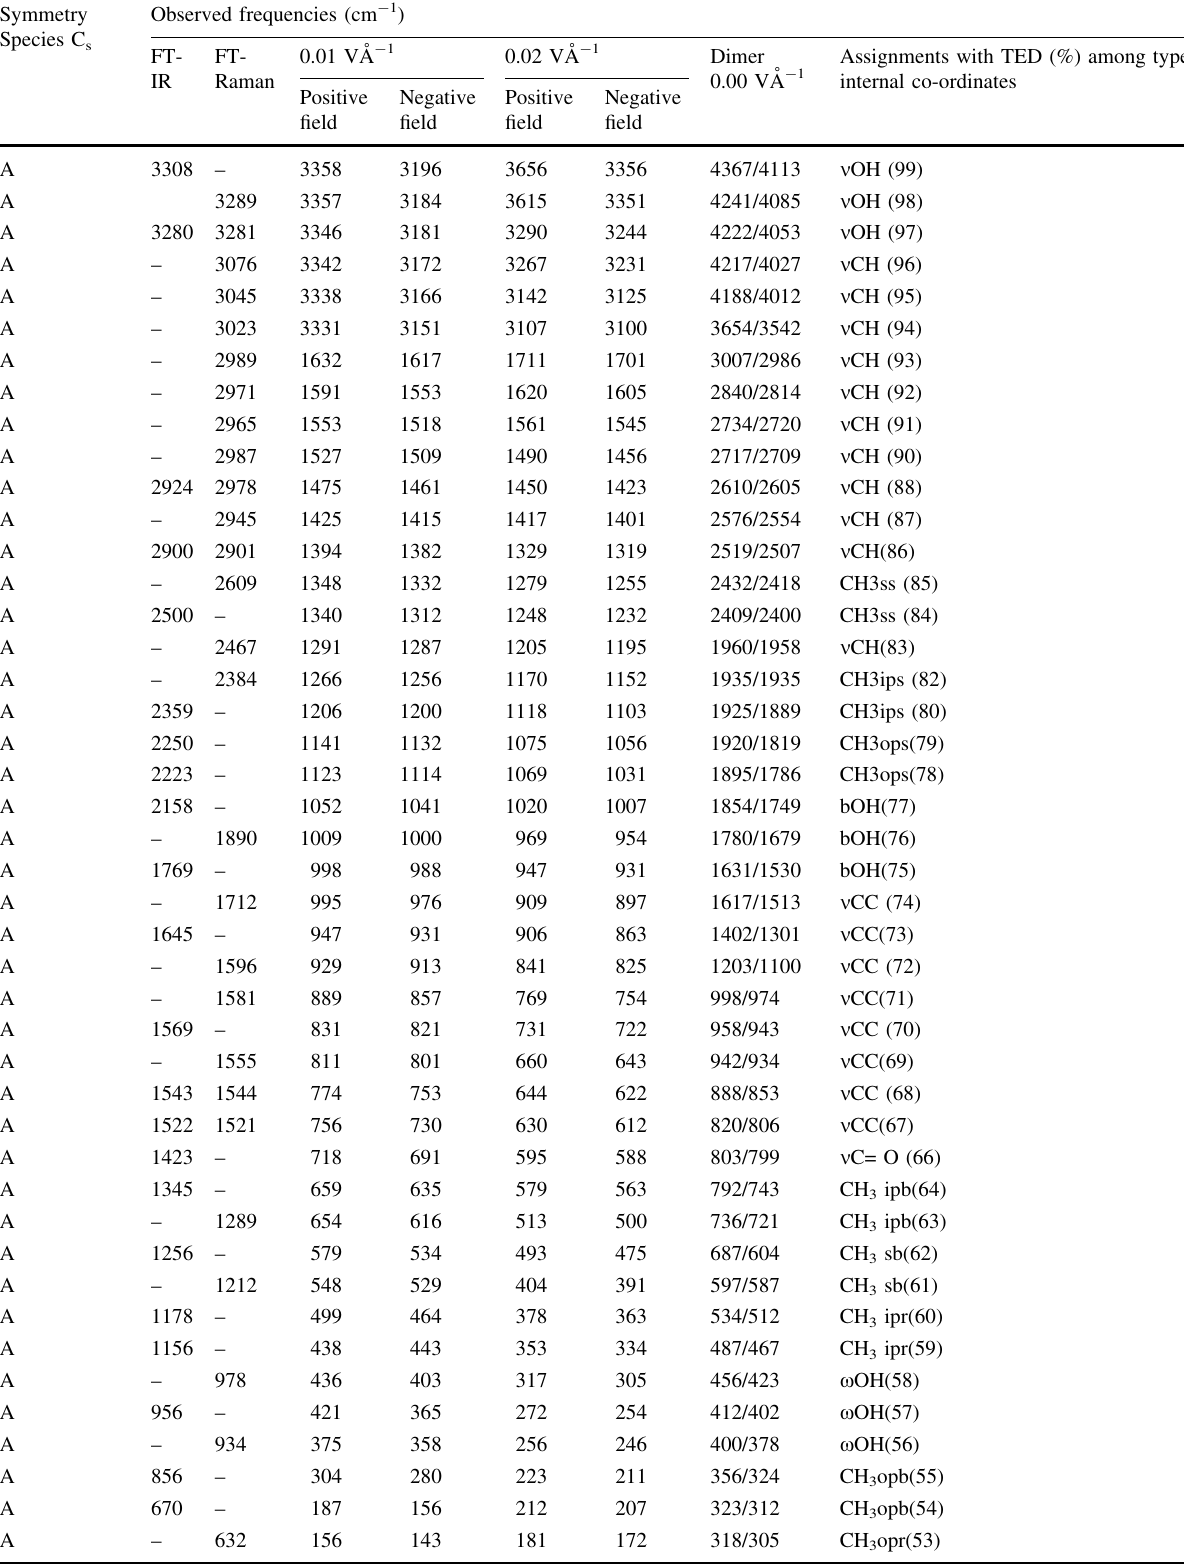
Table 3 The observed FT-IR and FT-Raman frequencies (cm - 1 ) for the Dimer, various applied electric fields (VA˚ - 1 ) and probable assignments (characterized by TED) of curcumin using B3LYP methods Symmetry Species C